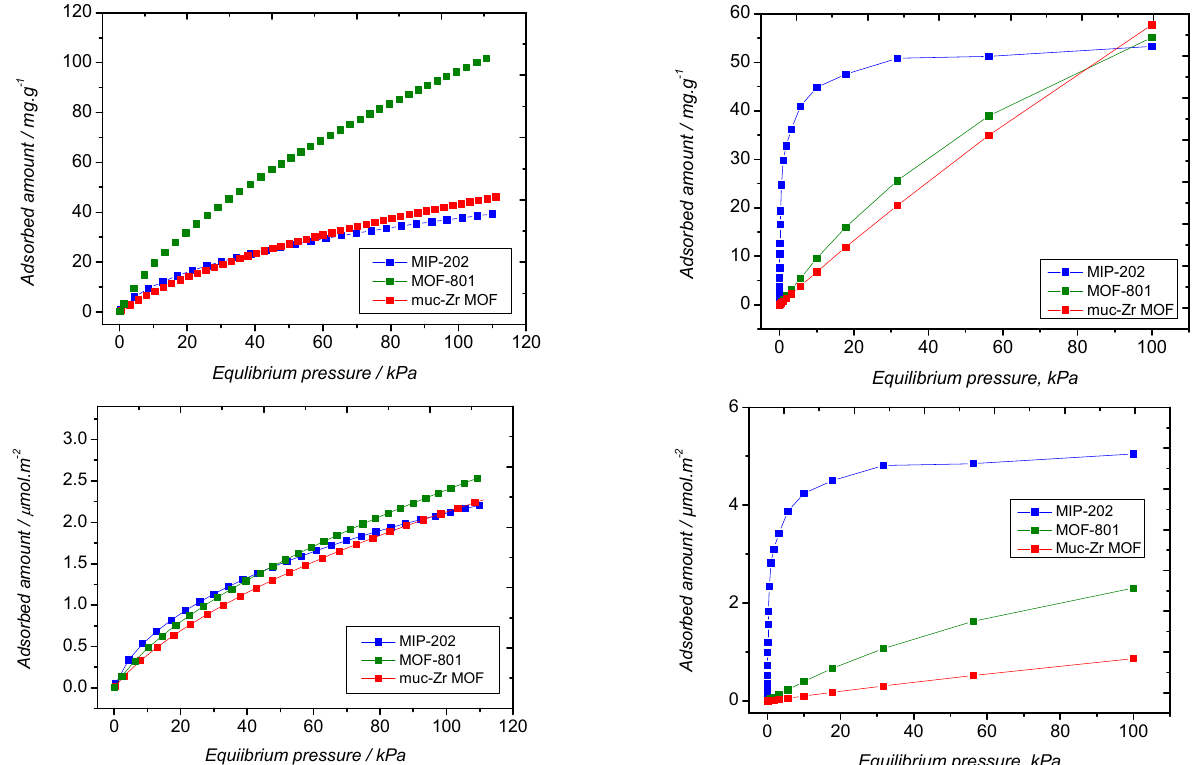
Figure 7. Carbon dioxide adsorption isotherms at 298 K by the prepared MOFs. (Red) Muc-Zr MOF, (green) MOF-801, (blue) MIP-202; ( top left ) experimental data, ( top right ) predicted data. Experimental data reported as per square meter. ( bottom left ) Simulated data reported as per square meter ( bottom right ).